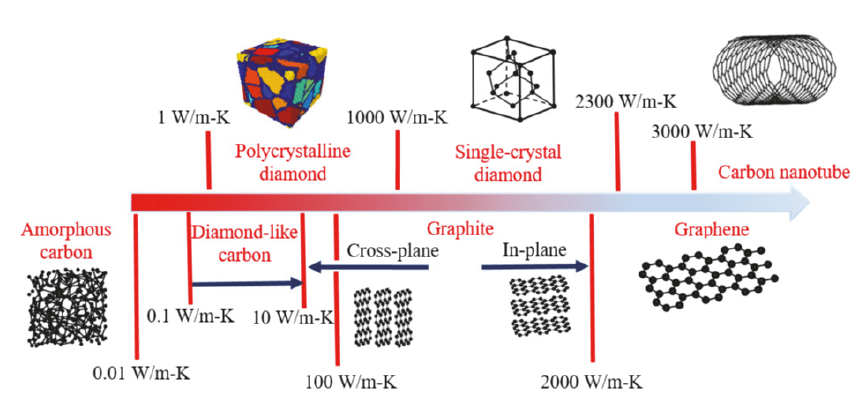
Figure 2: Illustration of the wide distribution of the thermal conductivity of carbon-based